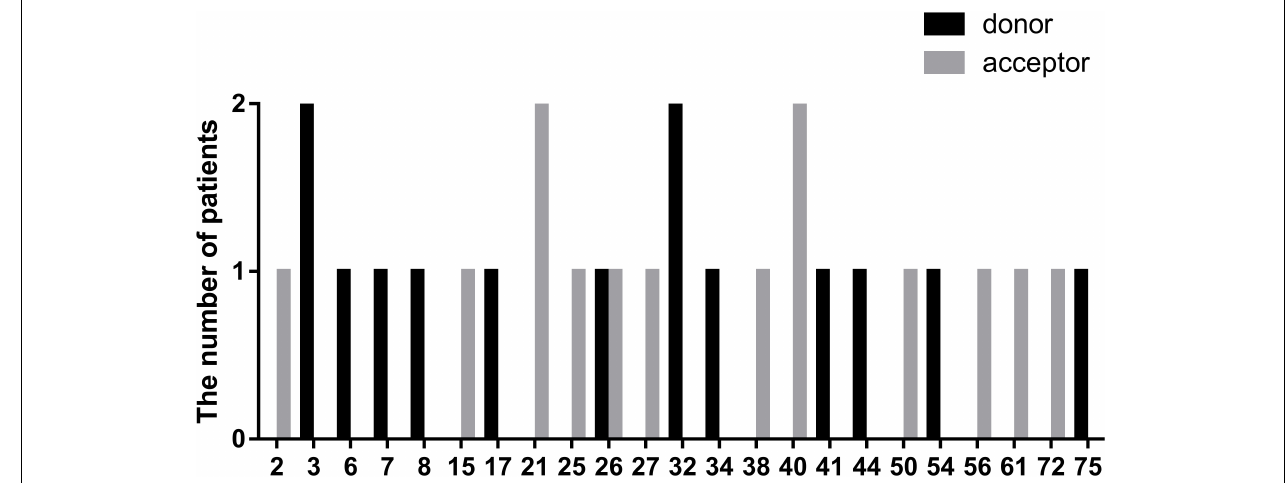
FIGURE 7 | Positional distribution of splicing mutations located in donor and acceptor